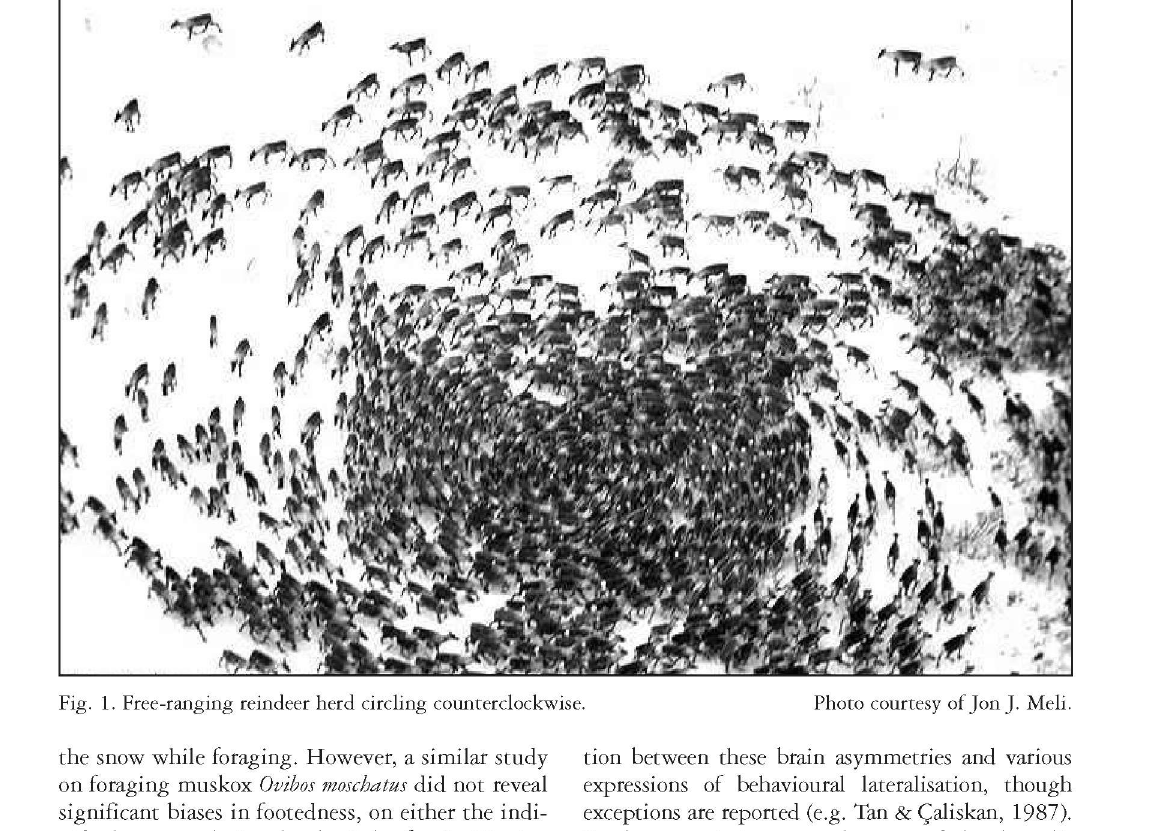
Fig. 1. Free-ranging reindeer herd circling counterclockwise. Photo courtesy of Jon J.